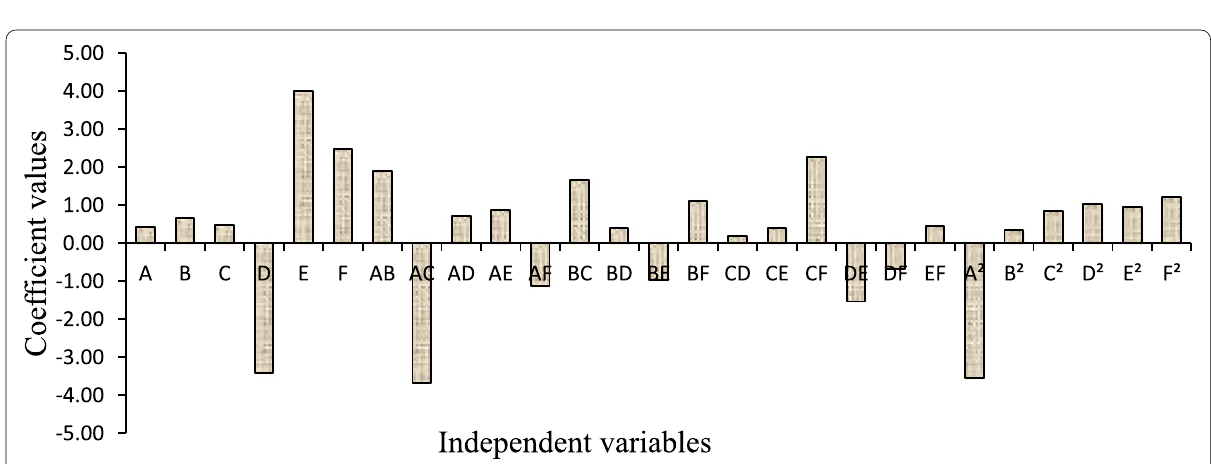
Fig. 5 Pareto chart showing the linear, interactive, and quadratic effects of different factors on the response bioethanol yield (Y E/S